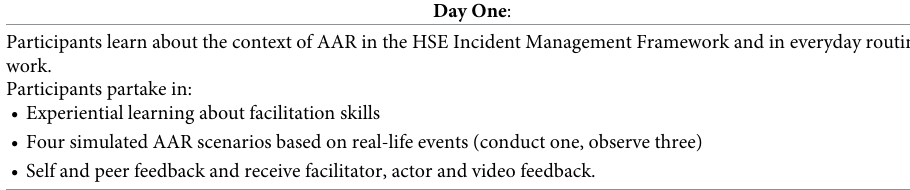
Table 1. HSE/RCSI simulation based after action review facilitator trsaining programme.